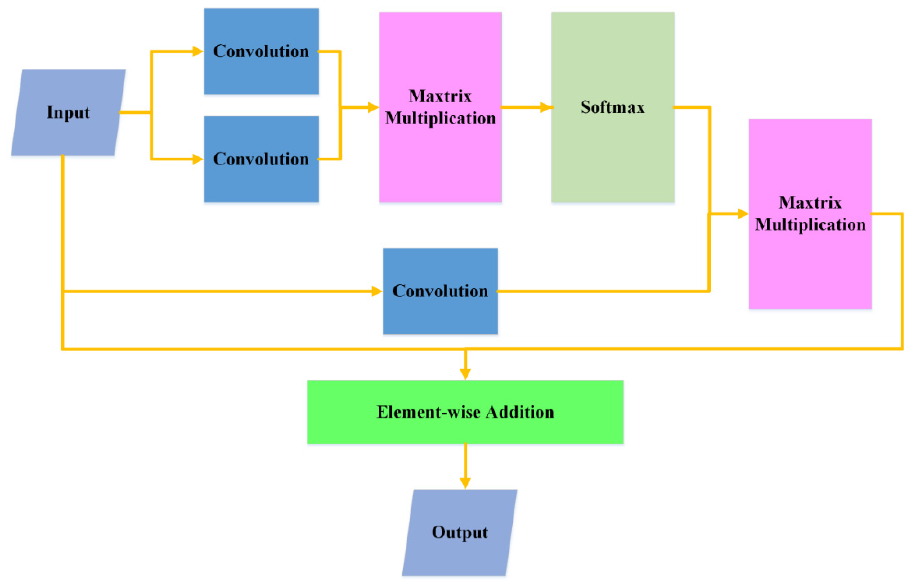
Figure 4. Detail architecture of our model.